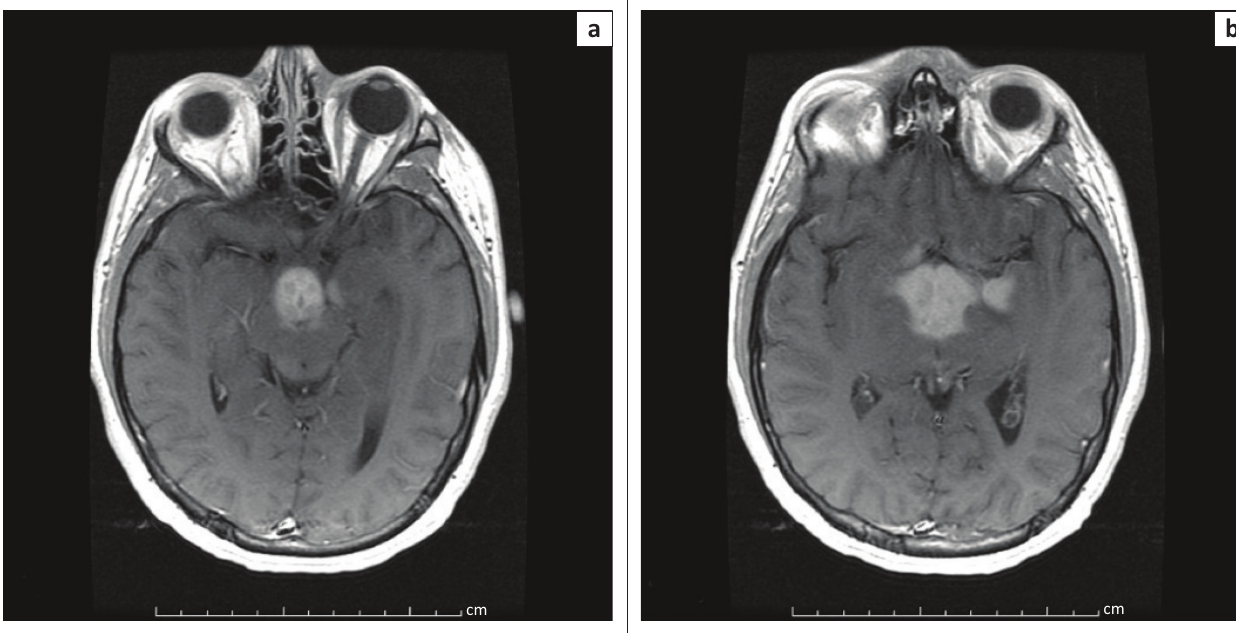
FIGURE 2: Axial T1-weighted post-contrast imaging (a and b) demonstrating avid enhancement corresponding to the regions of T2/FLAIR signal